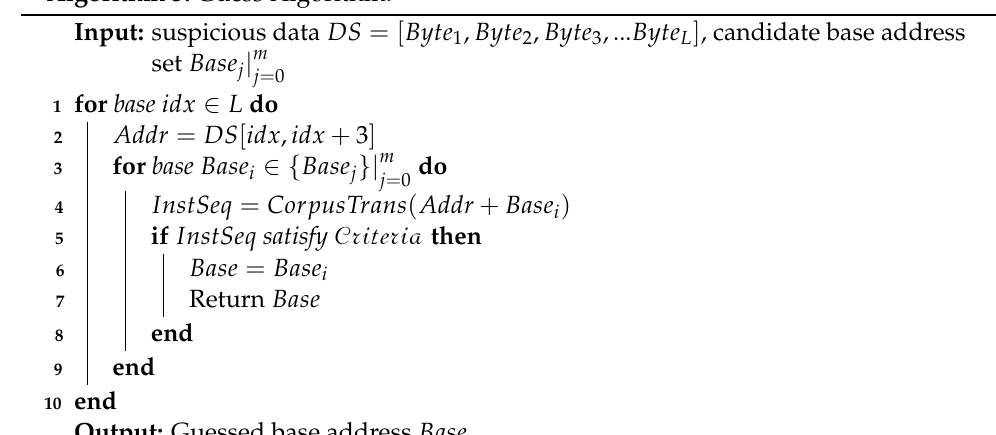
Algorithm 3: Guess